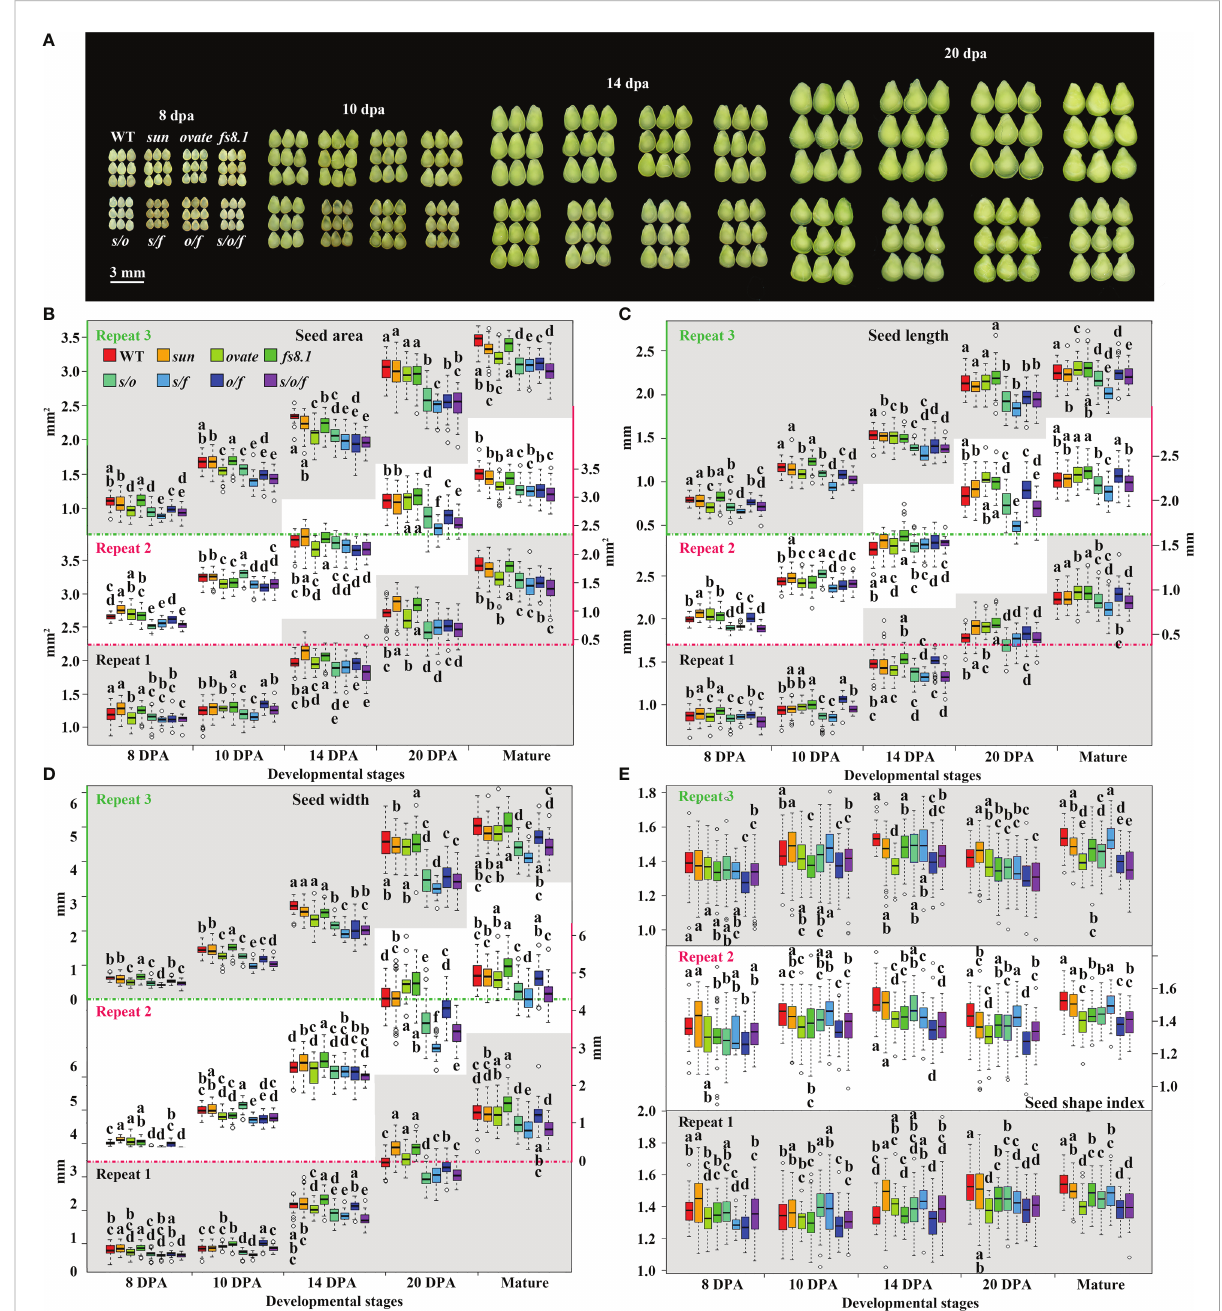
FIGURE 3 Comparisons of seed size and shape at different developmental stages in fruit shape NILs. (A) Representative seeds from eight genotypes at 8, 10, 14 and 20 dpa. (B) Changes in seed area from 8 dpa to 20 dpa. (C) Changes in seed length from 8 dpa to 20 dpa. (D) Changes in seed width from 8 dpa to 20 dpa. (E) Changes in seed shape index from 8 dpa to 20 dpa. Statistical analyses were performed using Turkey HSD tests at 0.05. Small alphabet letters above or below the boxes indicate the signi fi cance of the HSD